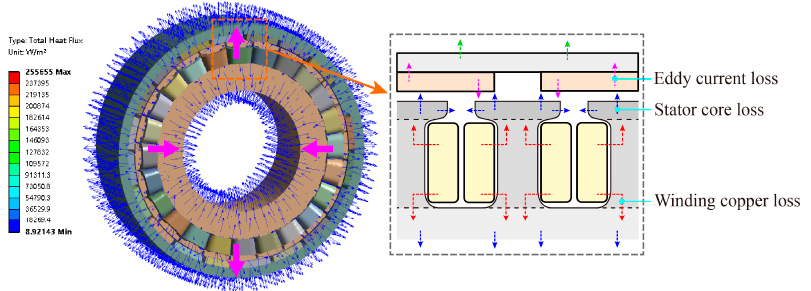
Figure 8. Thermal flux vector distribution of PM-IWM.